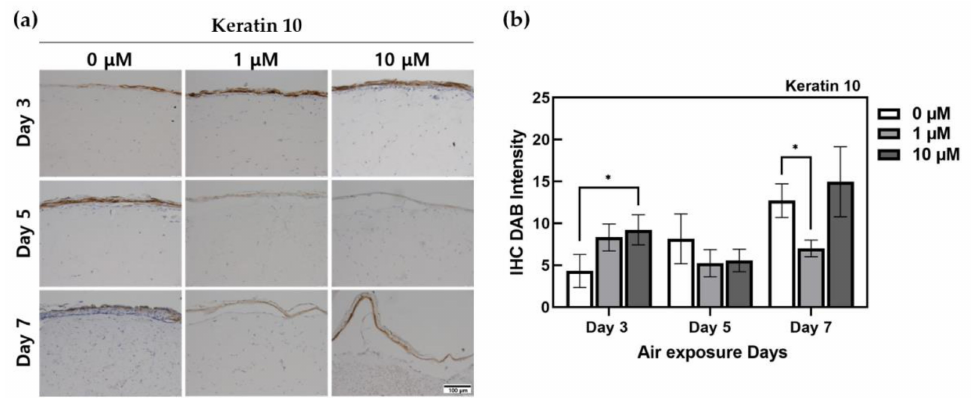
Figure 6. Immunohistochemistry-stained images for keratin 10 of HSEs treated α -lipoic acid concentration of 0, 1, and 10 µ M. ( a ) This is the result of keratin 10 expressed by IHC staining in HSEs. The x-axis is listed by ALA-treated concentration, and the y-axis is listed by ALA-treated period. The scale bar is 100 µ m. ( b ) This is a graph of quantification of DAB intensity for immunohistochemistry staining of Keratin 10 protein using the ImageJ program. ( n = 4; *, p < 0.05 vs. 0 µ M for each